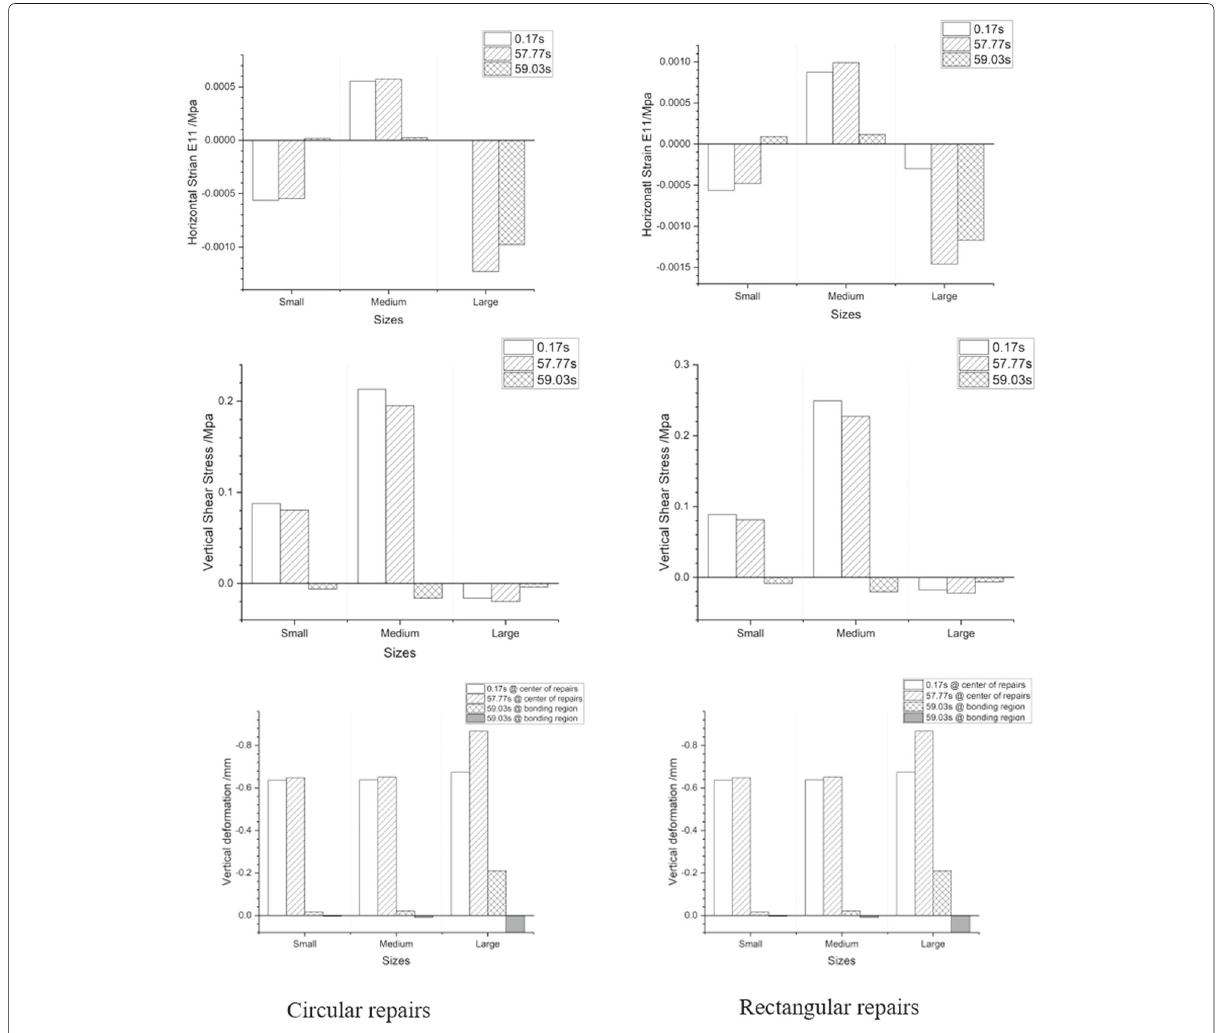
Fig. 11 Responses of pavements with circular and rectangular repairs at bonding areas